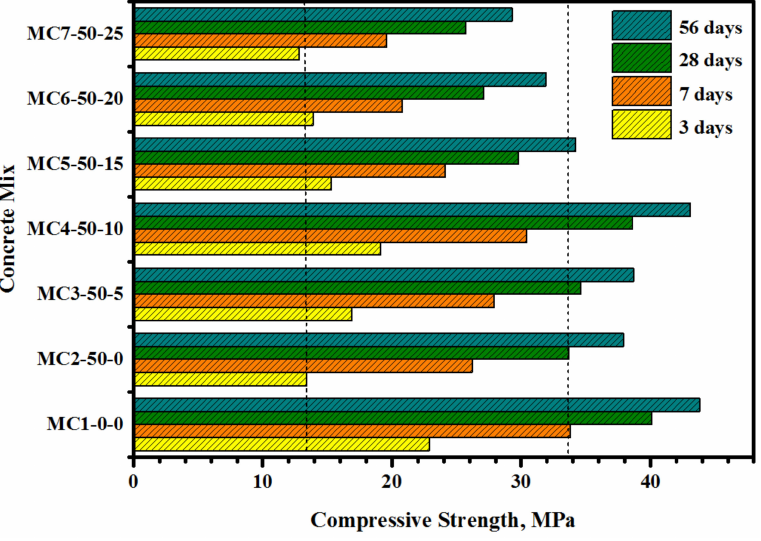
Figure 4. Influence of EM solution on the CS development of